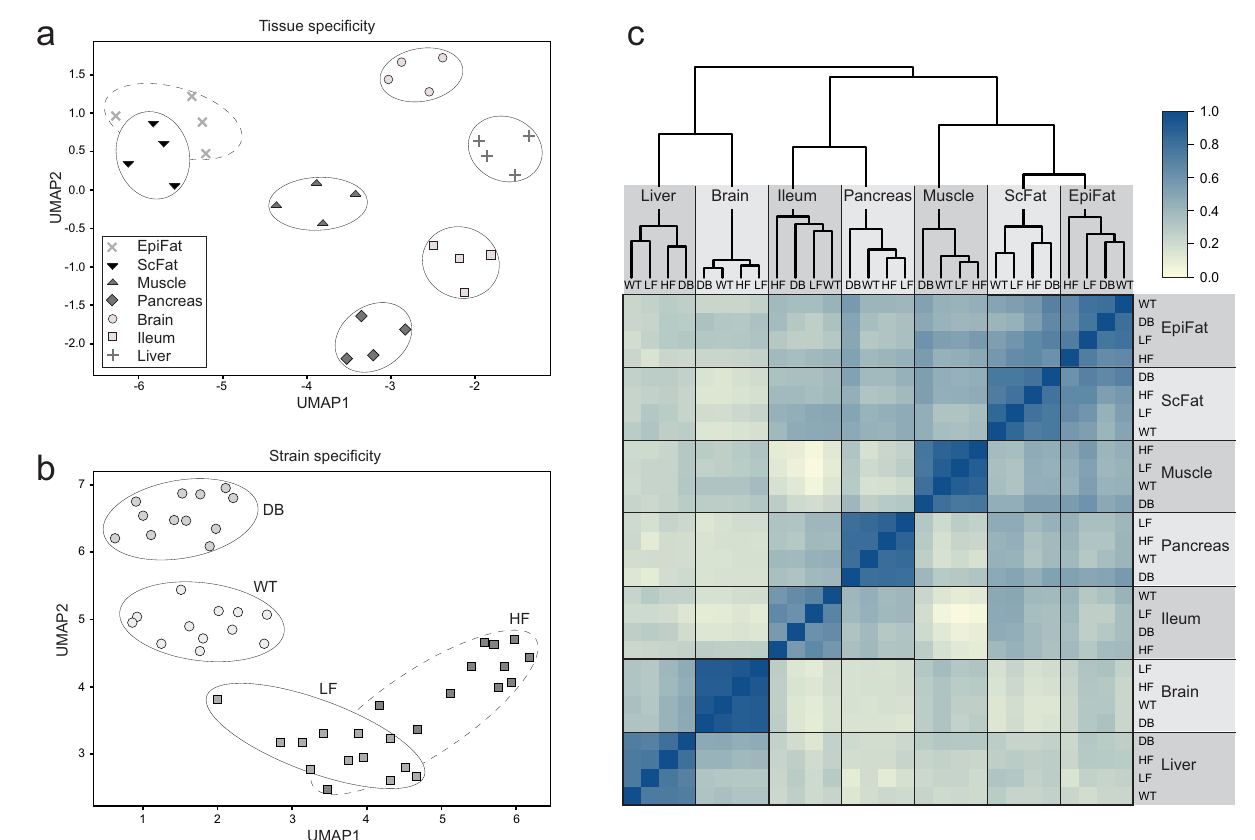
Fig. 2 | Diet and genetic background manifested at the peptide level. a Tissue speci fi city on entire dataset. Non-linear dimension reduction employing UMAP with imputed values on 1% quantile of lowest intensity peptides 61 . Average values from12animalsforeachstraintype;wildtype(WT),diabetic(DB),low-fatdiet(LF),